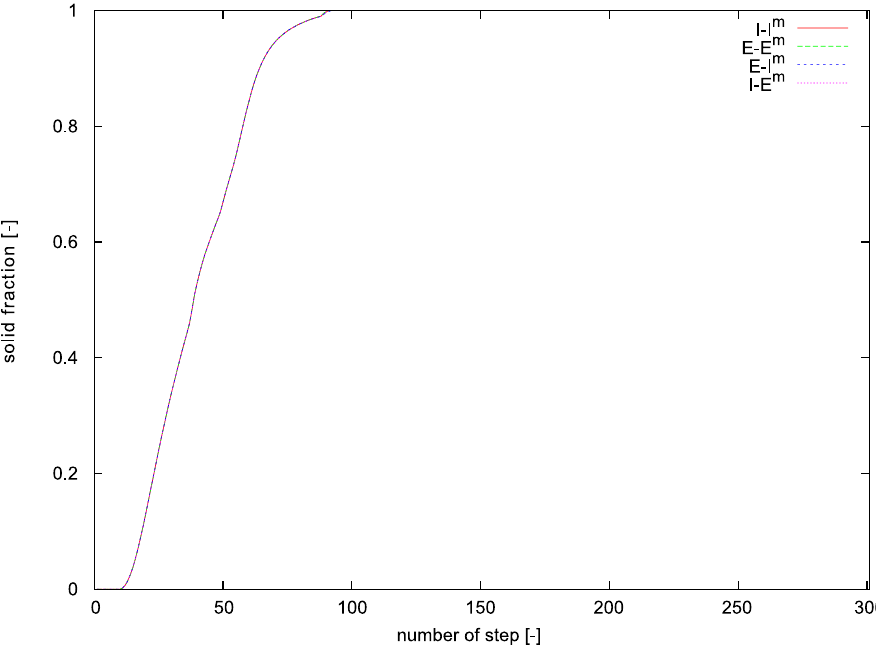
Figure 9. Solid phase growth obtained for selected point in casting domain. Solid phase fraction for multiplication factor m = 1 calculated by mixed time partitioning